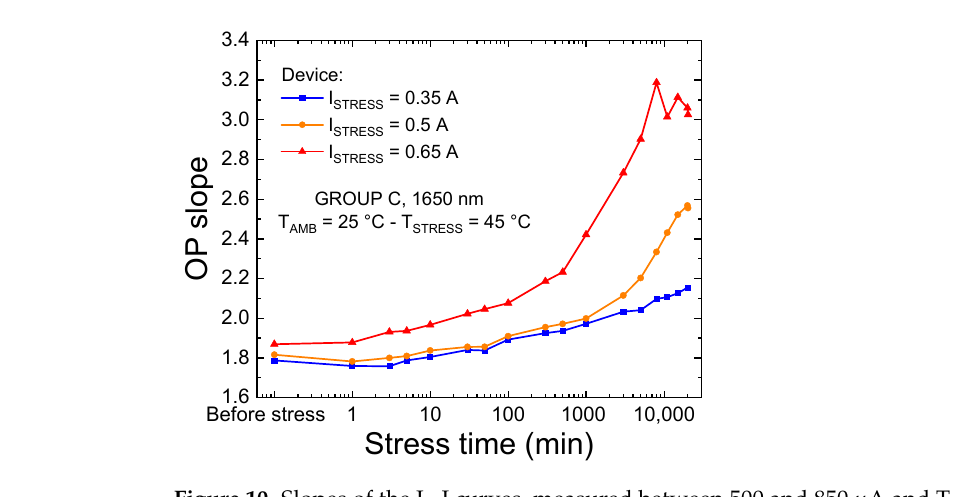
Figure 10. Slopes of the L–I curves, measured between 500 and 850 μ A and T AMB = 25 °C, during the three constant-current stresses carried out on group C LEDs at T SRESS = 45 °C.